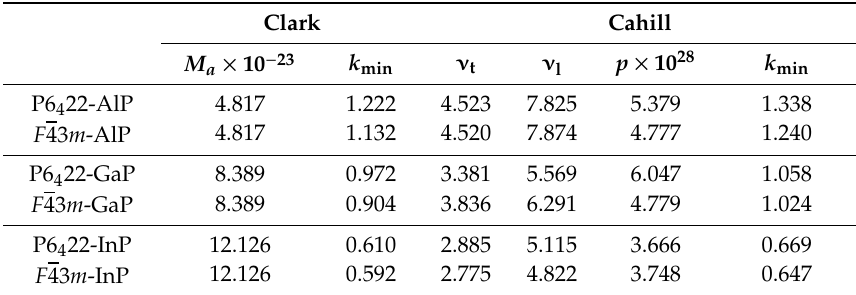
Table 4. Average mass per atom, M a / g; the transverse and longitudinal sound velocities, ν t, ν l / (km · s − 1 ); thedensityofnumberofatompervolume, p ; andtheminimumthermalconductivityathightemperature, modulus E , density of the crystal ρ , bulk moduli B , and shear moduli G